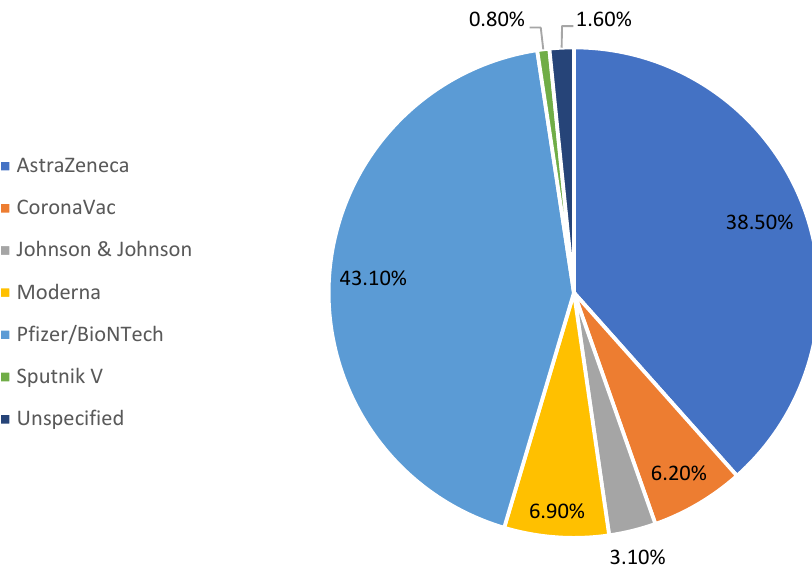
Figure 2. Types of COVID-19 vaccine used in patients with ophthalmic vascular event .